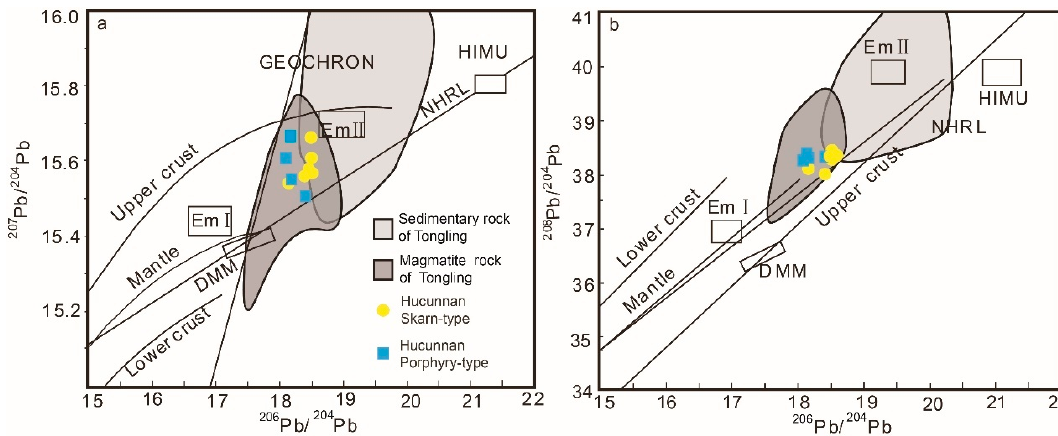
Figure 15. Pb isotope of the Tongling ore-cluster region [28]: ( a ) 207 Pb/ 204 Pb– 206 Pb/ 204 Pb; ( b ) 208 Pb/ 204 Pb– 206 Pb/Pb. DMM, depleted mantle component; EM I and II, enriched mantle components [94]; Geochron, zero isochron line; NHRL, northern hemisphere reference line [95]. Lines of mantle, lower crust, and upper crust of China are after [96].